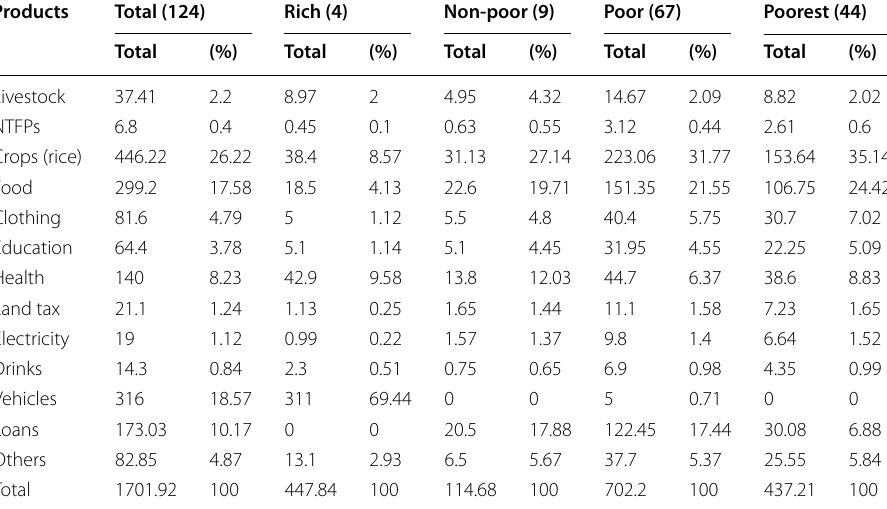
Table 6 Total household expenditures by household groups in the village (1 million